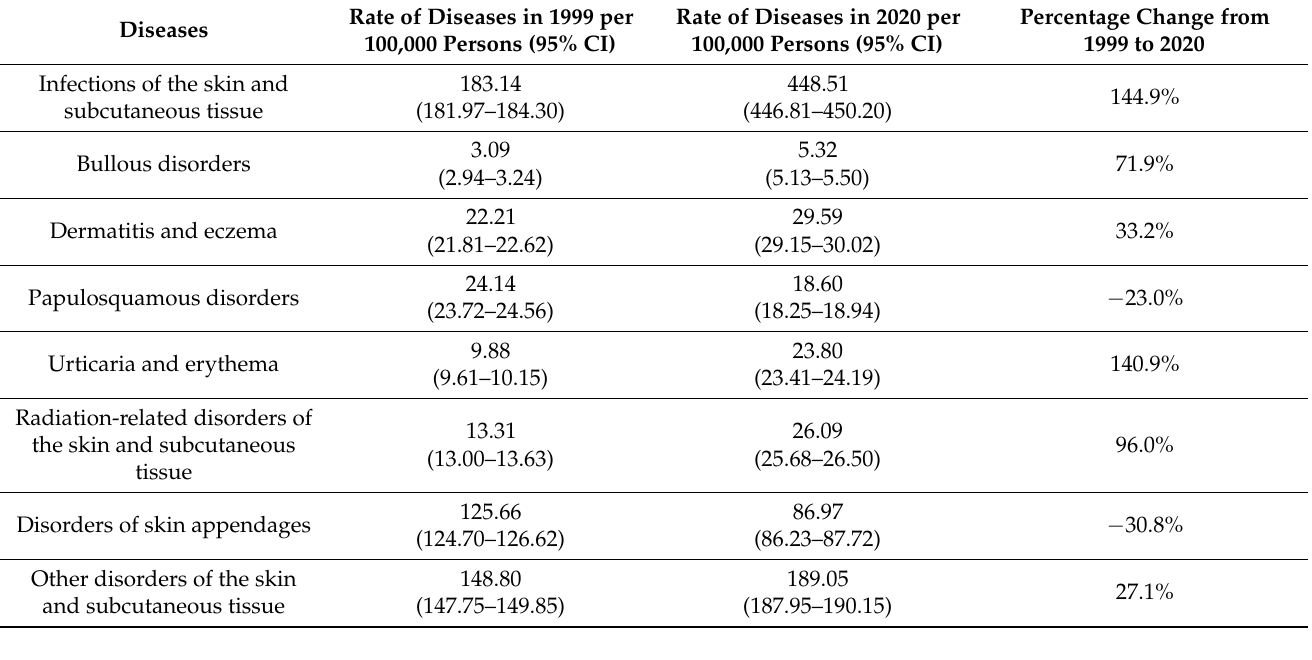
Table 2. Percentage change in hospital admission rates from 1999 to 2020 in England and Wales.